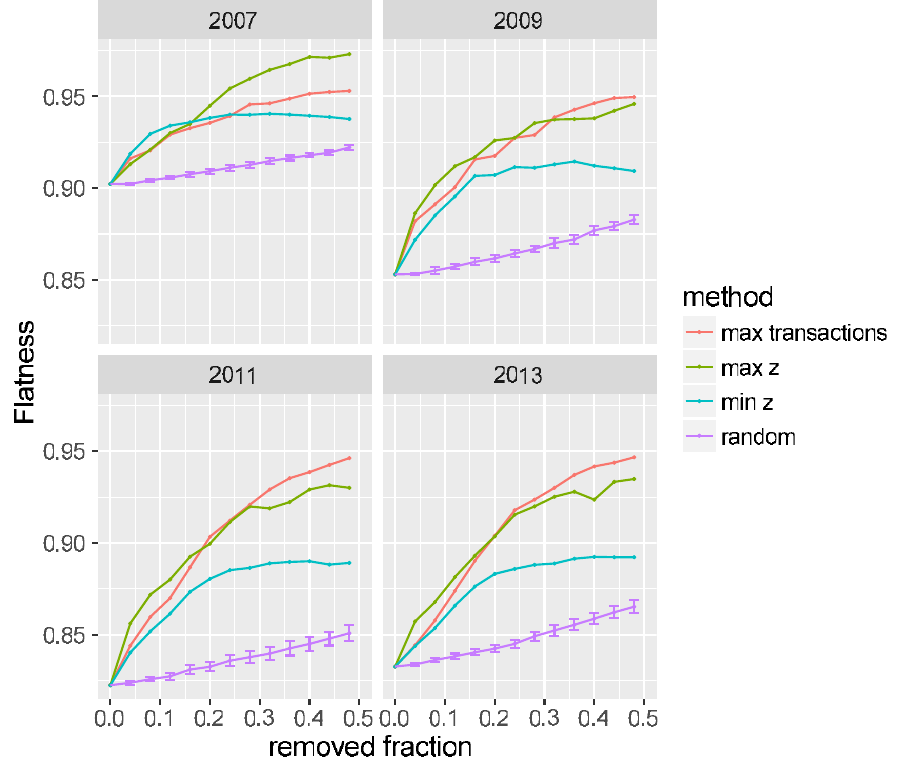
Fig 7. Simulated shocks: The effect of link removal. Change in flatness (defined as the fraction of unbiased links in the network) as a function of removed fraction of links for different selection methods and for a few selected years (other years show a similar trend). The error bars correspond to ± 2 standard error for the random link removal case. Similar to the node removal case, the system flatness does not change appreciably as links are removed randomly. Removing biased links (i.e., maximum or minimum z-scores) and links with maximum transactions makes the system flatter.